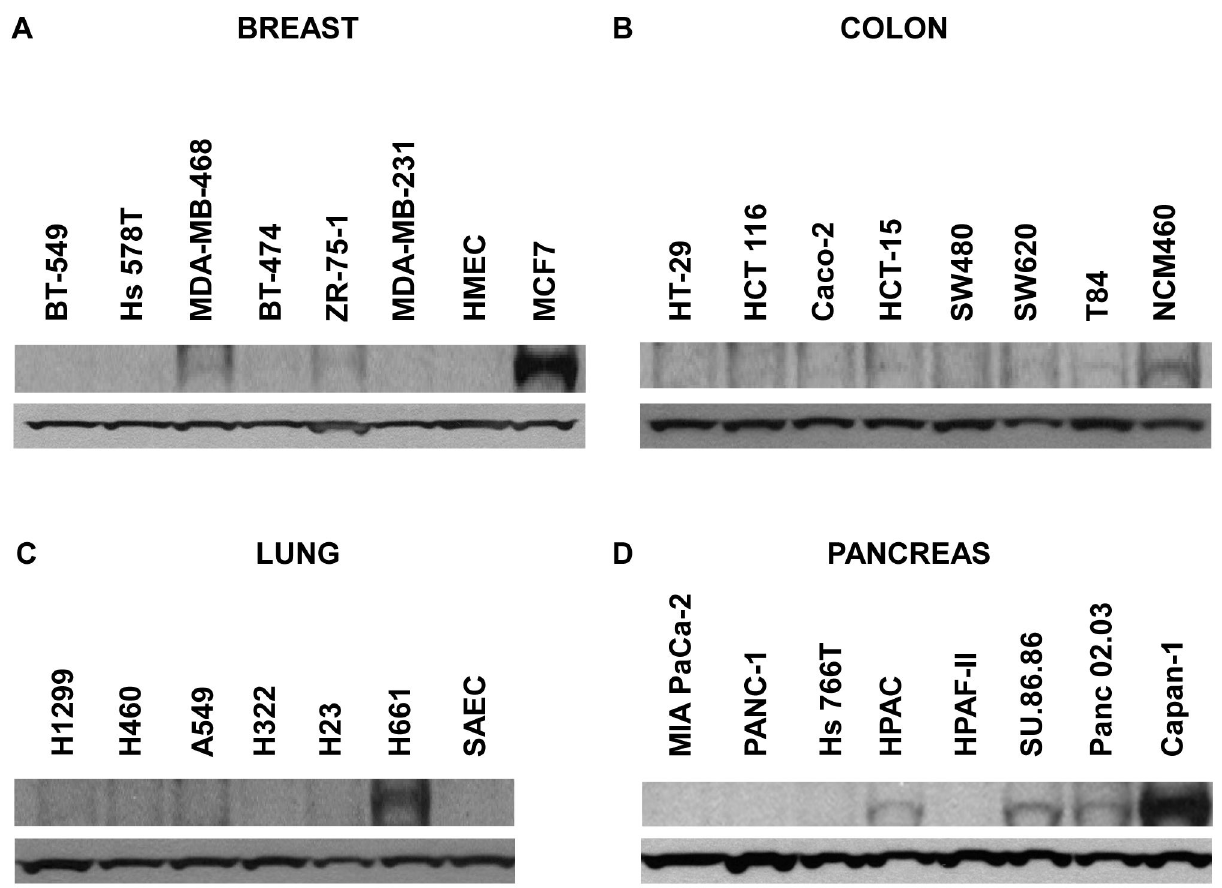
Figure 2. Differential expression of FILIP1L protein in various human cancer cell lines. Immunoblot analysis for FILIP1L in the same cells utilized in Figure 1. GAPDH blot is shown as the loading control. The result is representative of three independent